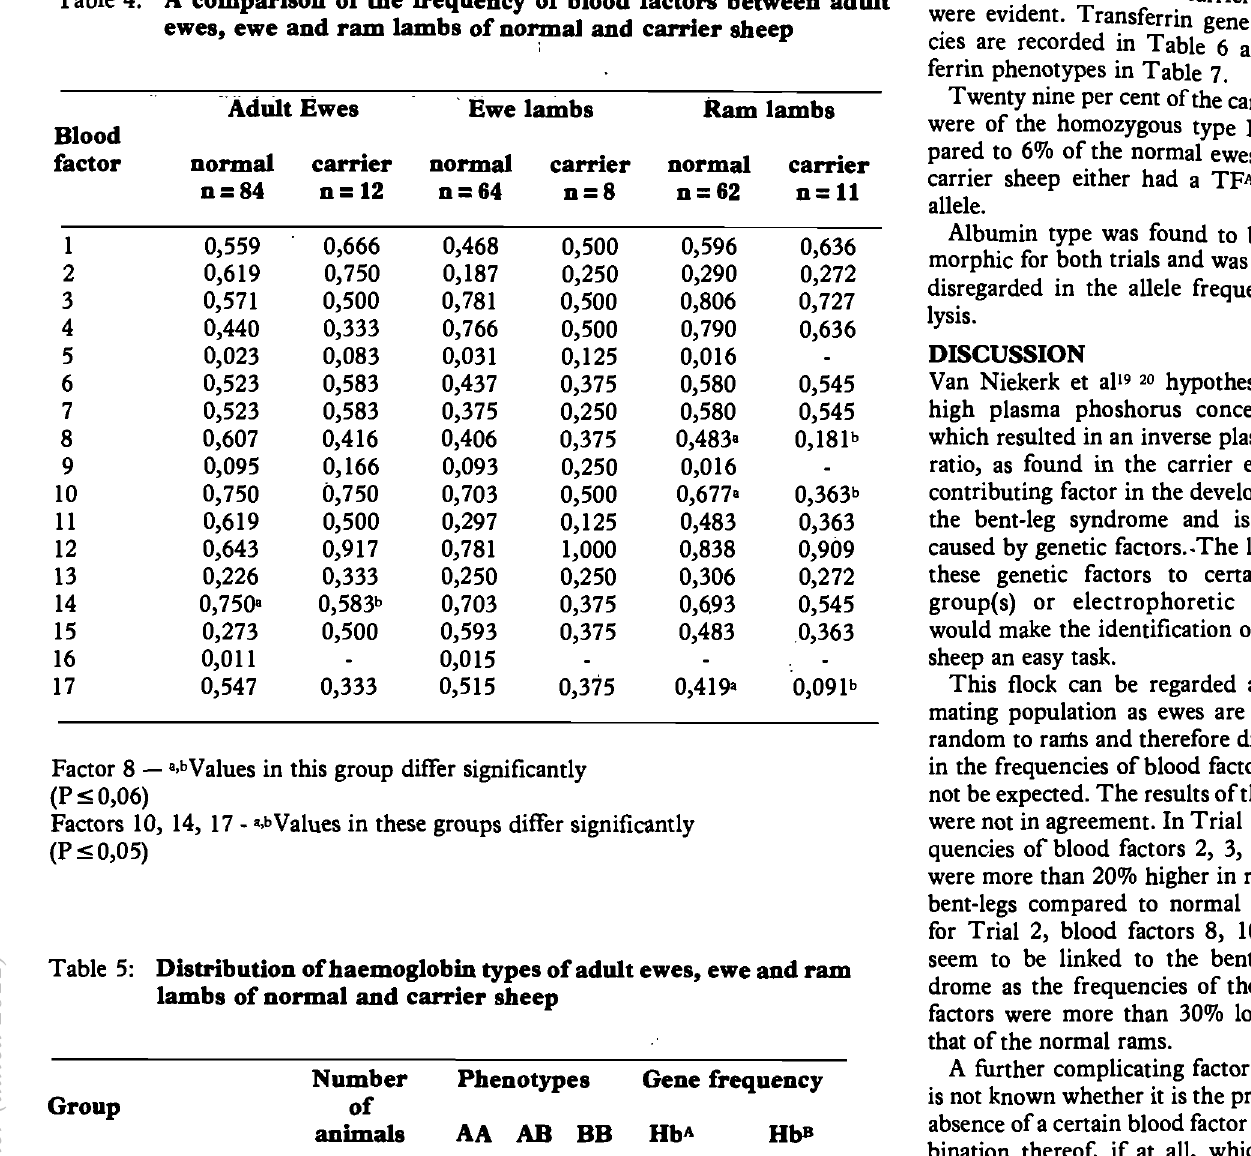
Group Ewes (normal)